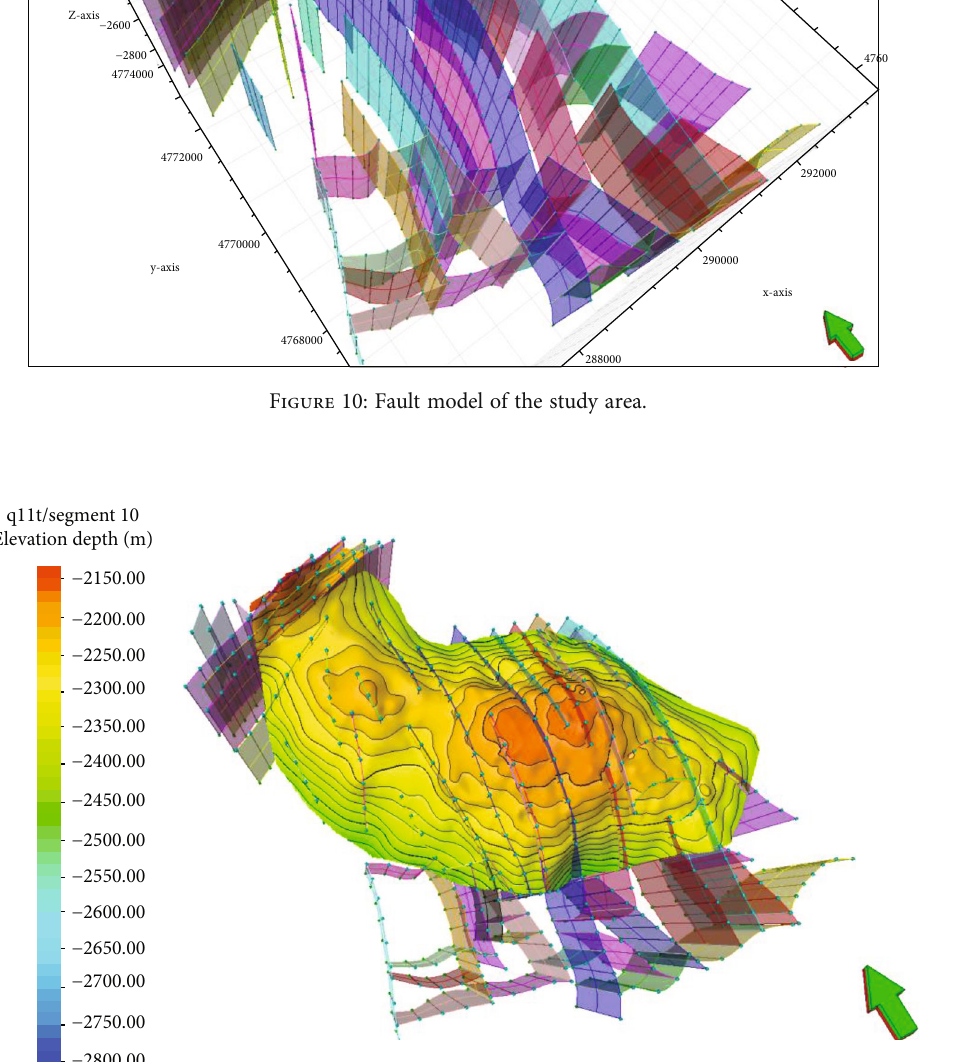
Figure 11: Top structure of the study